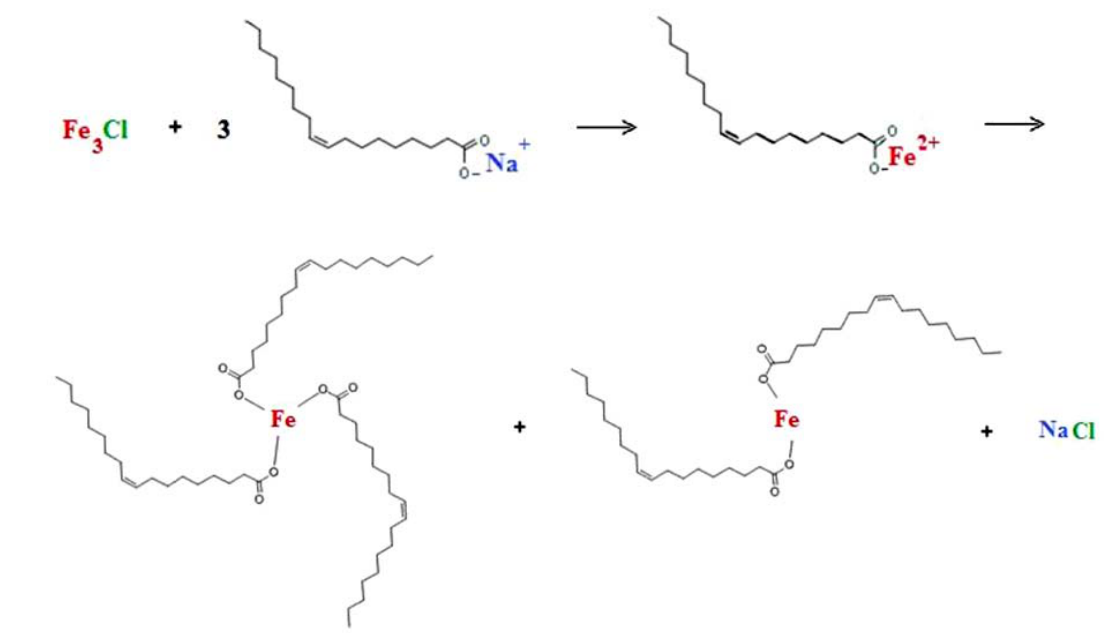
Figure 8. Formation of iron oleate complex from sodium